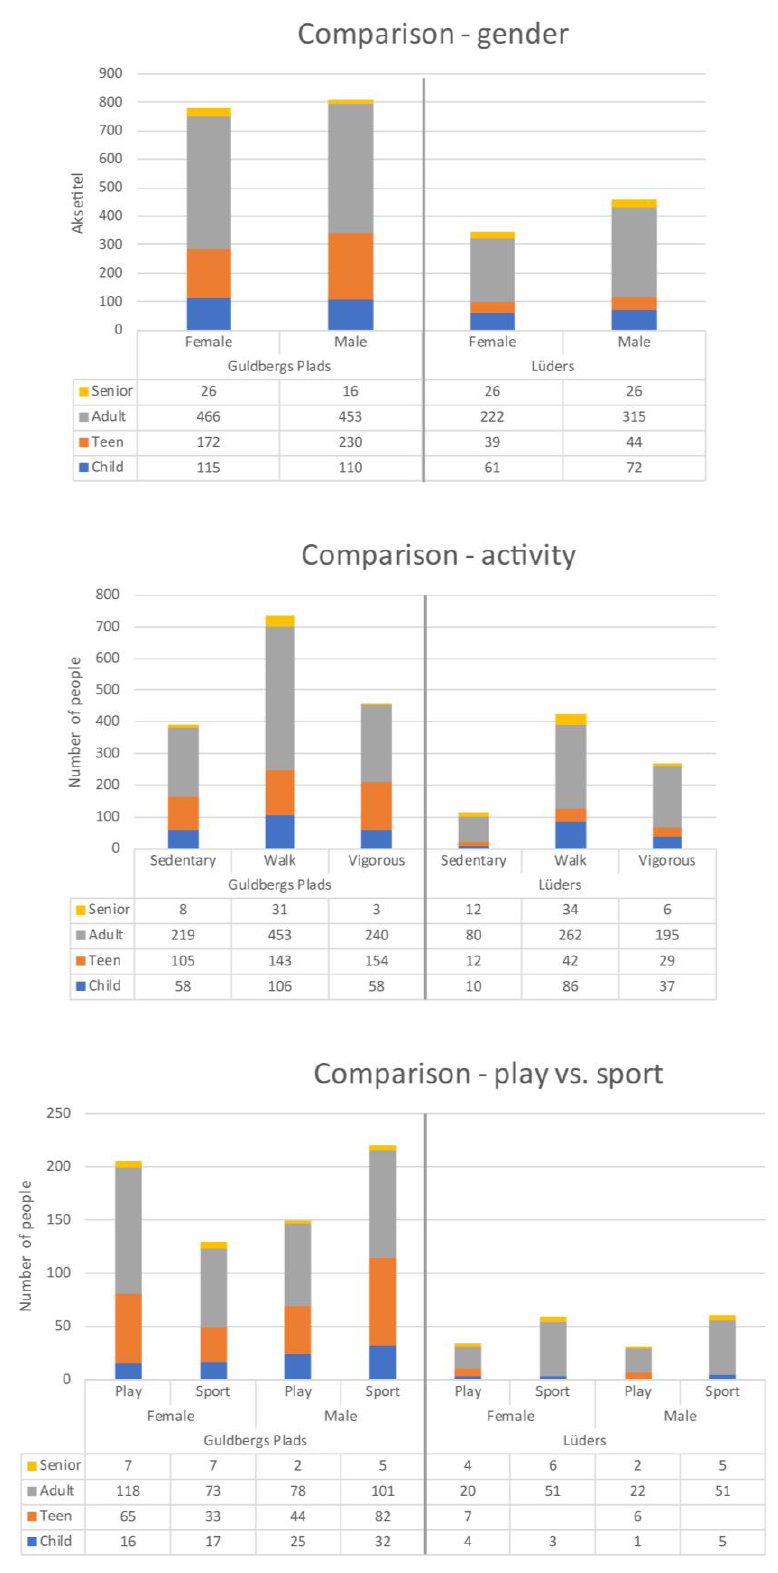
Figure 7. A comparison between Lüders parking roof and Guldbergs Plads regarding gender, activity and play vs. sport. and play vs.